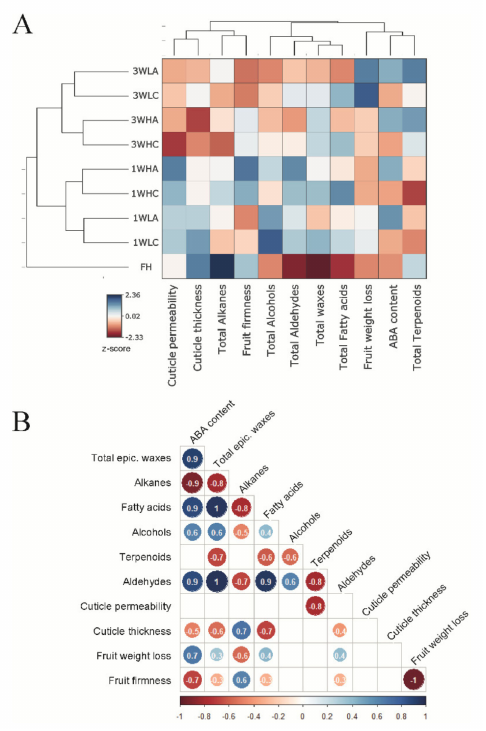
Figure 5. Clustering and correlation analyses of epicuticular wax composition, ABA content, cuticle properties and fruit physiological parameters in Pinalate fruit. ( A ) Hierarchical clustering analysis of the Pinalate fruit left at high (H, 90–95%) or low (L, 30–35%) RH for 1 week or 3 weeks (W), and treated (A, ABA) or not (C, control) with 1mM ABA, based on the chemical composition of their epicuticular wax layer, ABA content, cuticular properties and fruit physiology. The colors in the heatmap indicate the z-score value for each parameter and condition according to the scale in the legend. ( B ) Correlation matrix among the abundance of individual epicuticular wax fractions, ABA content, cuticle properties and fruit physiological parameters in the Pinalate fruit left under the above-described conditions. Numbers indicate the regression coefficient value, and only the statistically significant ones are colored according to the scale in the